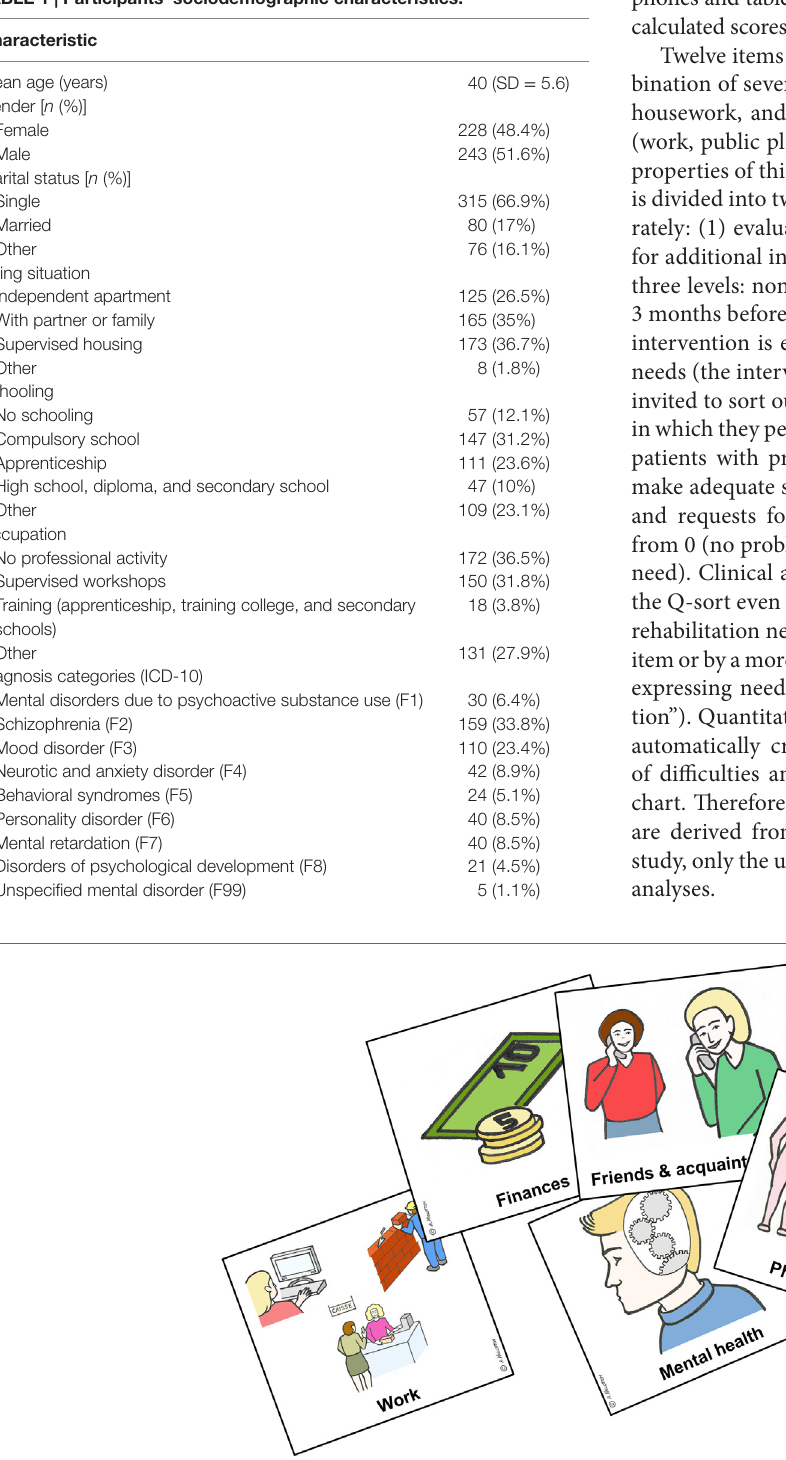
TaBle 1 | Participants’ sociodemographic characteristics.